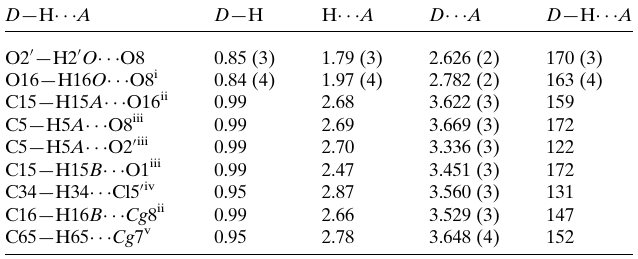
Table 1 Hydrogen-bond geometry (A˚ , (cid:3) ). Cg 7 and Cg 8 are the centroids of the C31–C36 and C61–C66 phenyl rings, respectively.